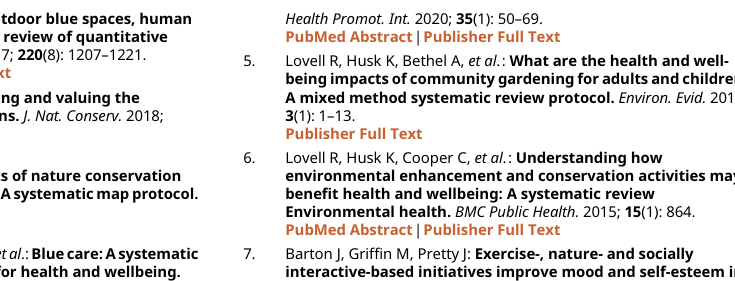
Figshare: Underlying data for ‘ Assessing the impacts of conservation volunteering on participant well-being: a simplified systematic review protocol ’ , https://doi.org/10.6084/m9.figshare.19525615.v1. 27 Data are available under the terms of the Creative Commons Zero “ No rights reserved ” data waiver (CC0 1.0 Public domain